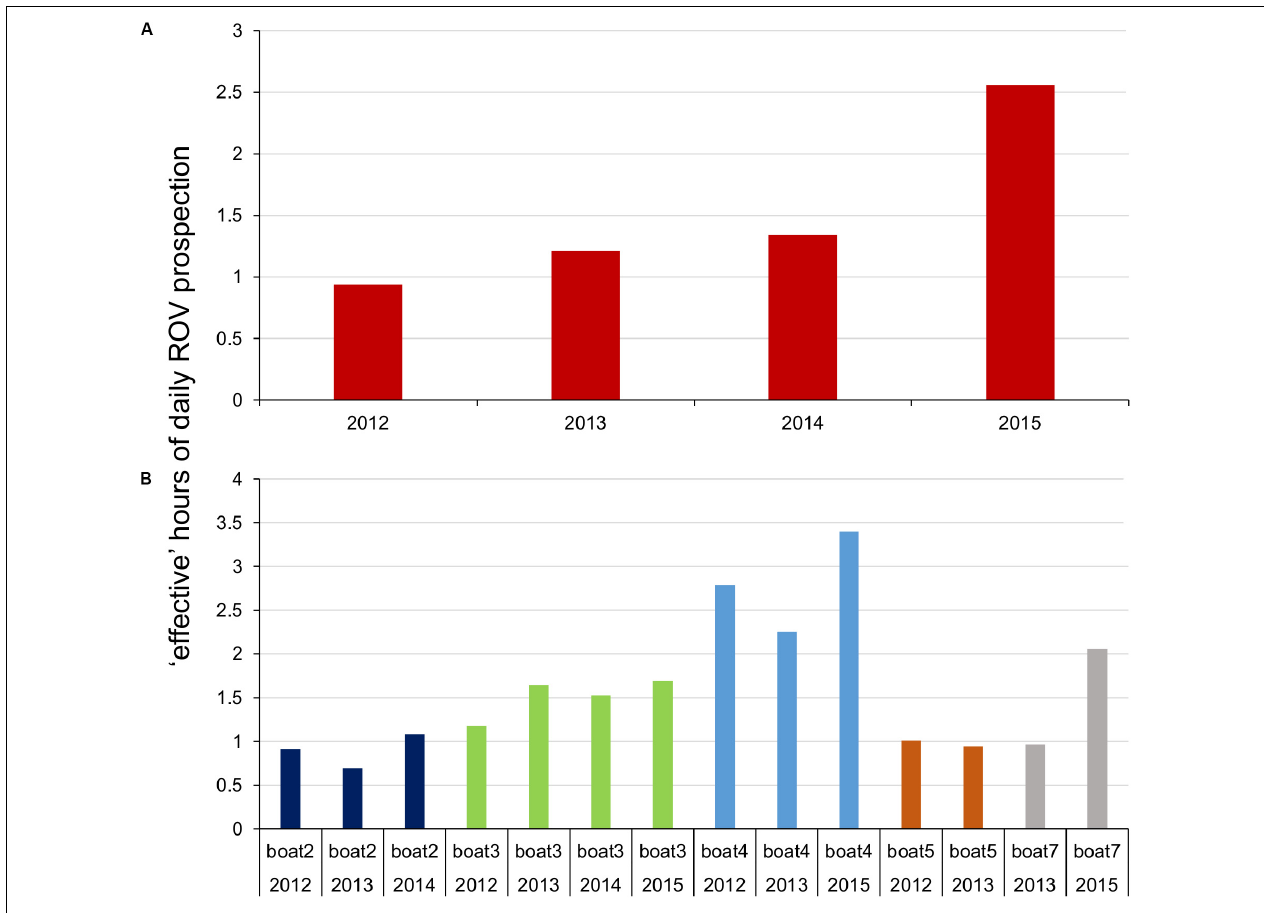
FIGURE 3 | Hours of daily ROV prospection reported for each year (A) and each boat (B) , from 2012 to